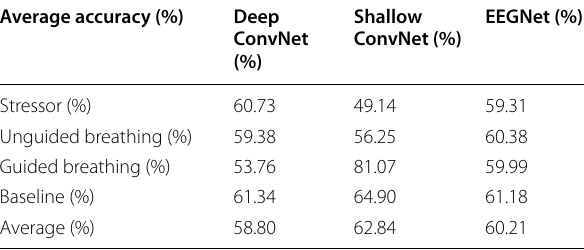
Table 2 Class‑wise and overall accuracies for the Deep ConvNet, Shallow ConvNet, and EEGNet CNN classifiers